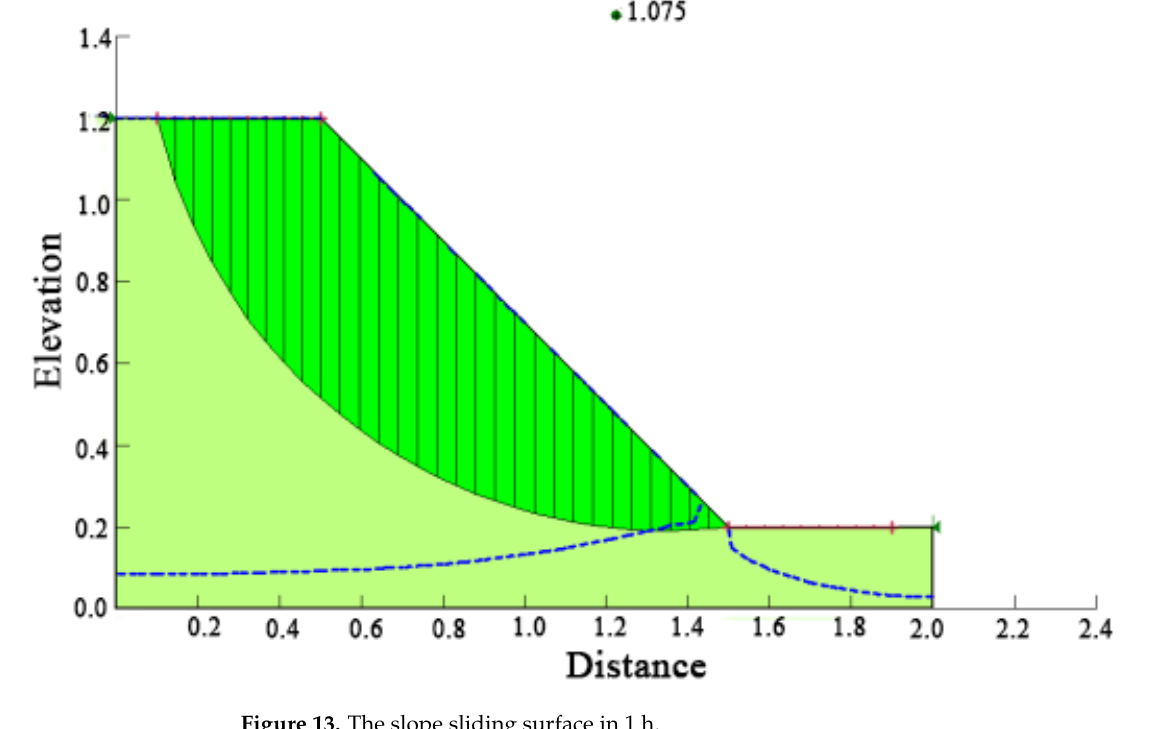
Figure 13. The slope sliding surface in 1 h.